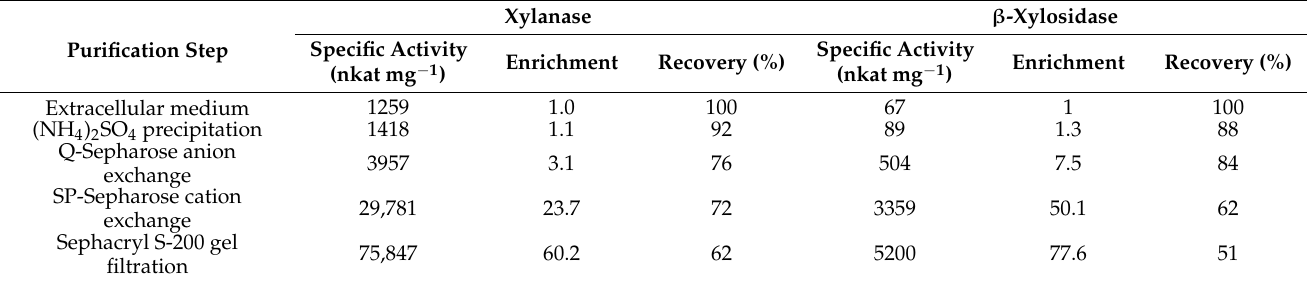
Table 1. Summary table of the steps followed for the purification of PvXyn11A and PvXyd3A.